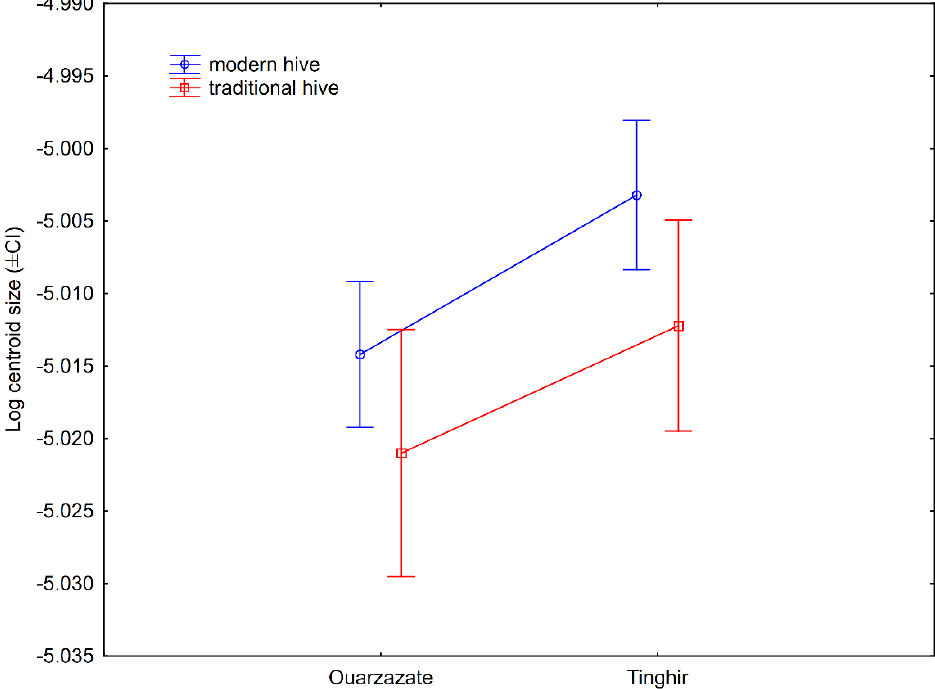
Figure 6. Difference between wing size ( ± 95% confidence intervals) in modern and traditional hives in two areas of south-eastern Morocco.